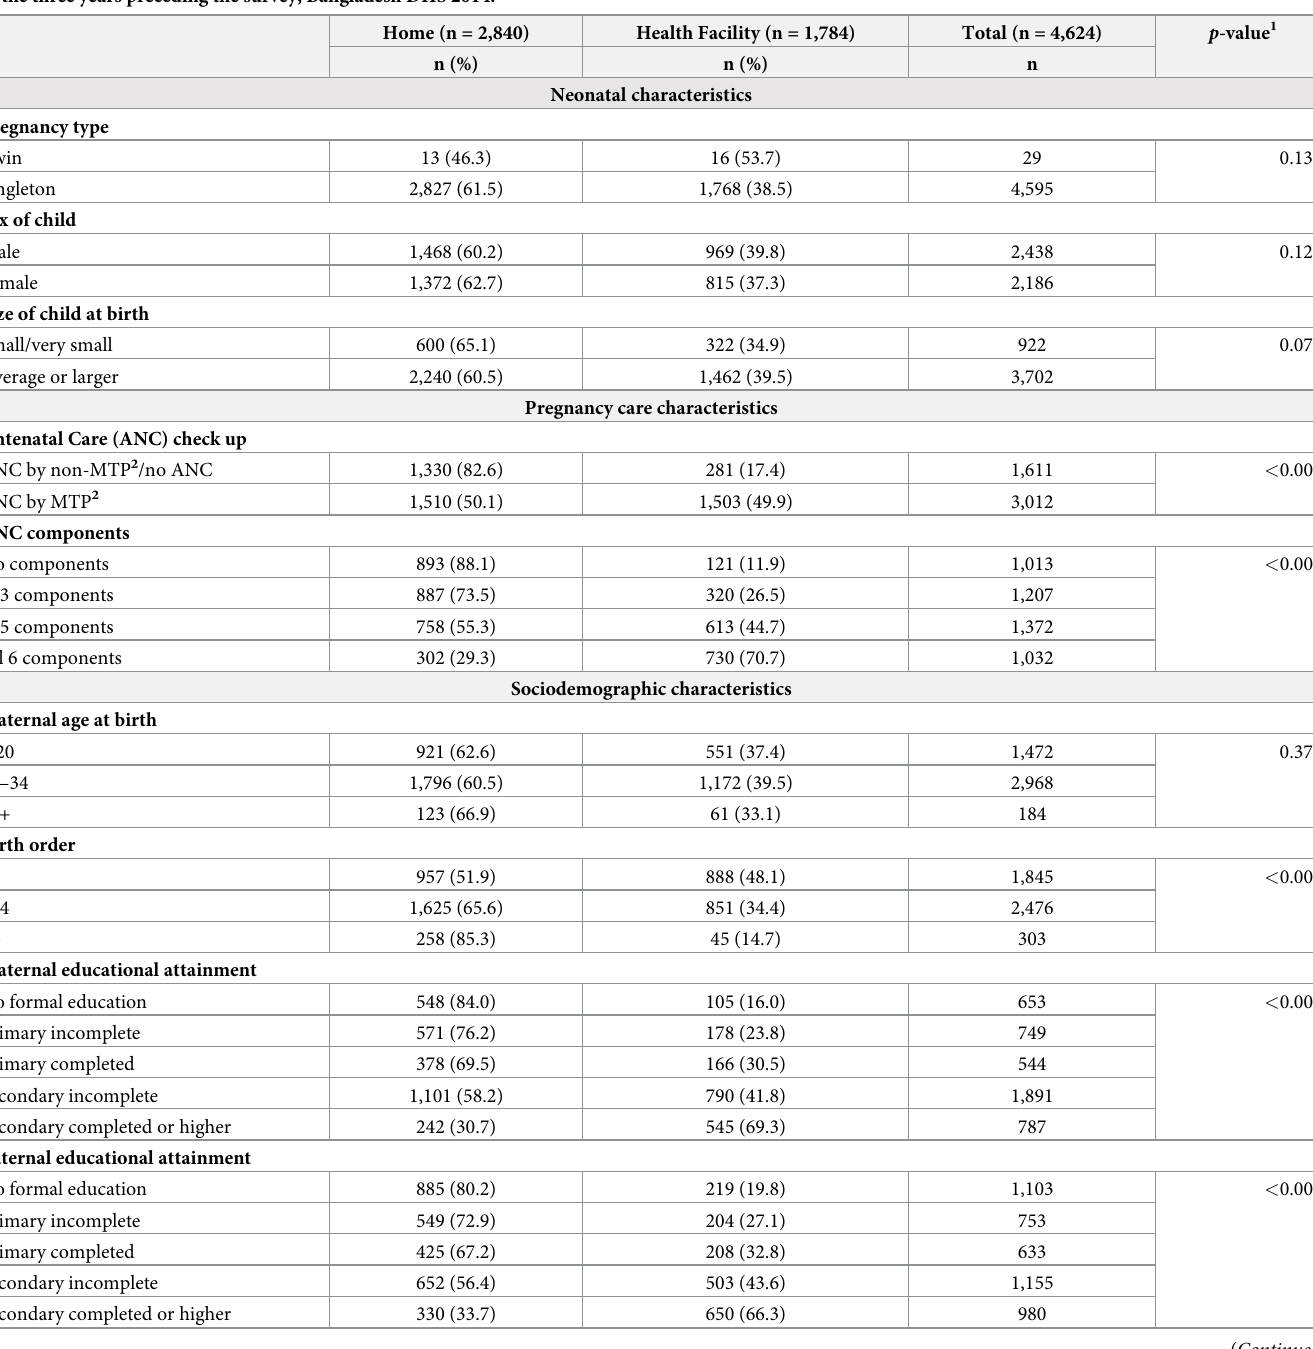
Table 3. Distribution of place of delivery by neonatal, pregnancy care, maternal, and socio-demographic/community characteristics among most recent live births in the three years preceding the survey, Bangladesh DHS 2014. Home (n =